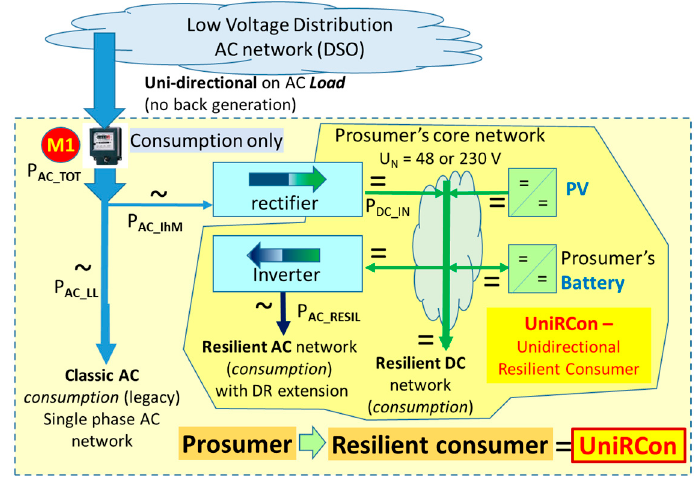
Figure 4. Proposed resilient architecture of the advanced prosumer ( UniRCon ).